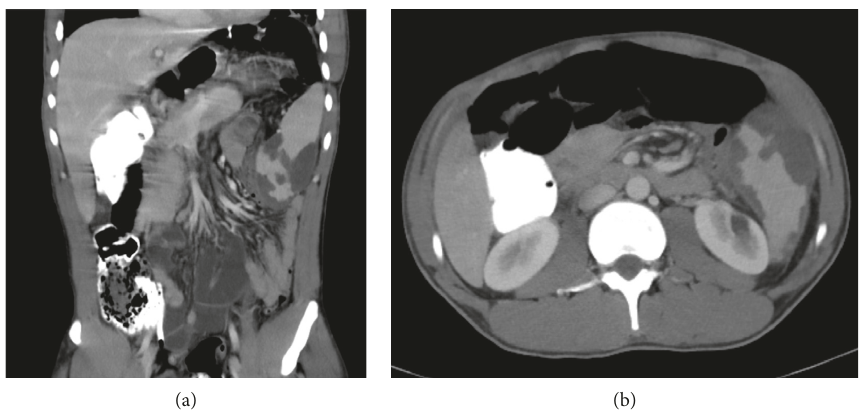
Figure 1: Coronal (a) and transverse (b) sections of the abdominal computed tomography scan showing multiple subcapsular hematoma in the